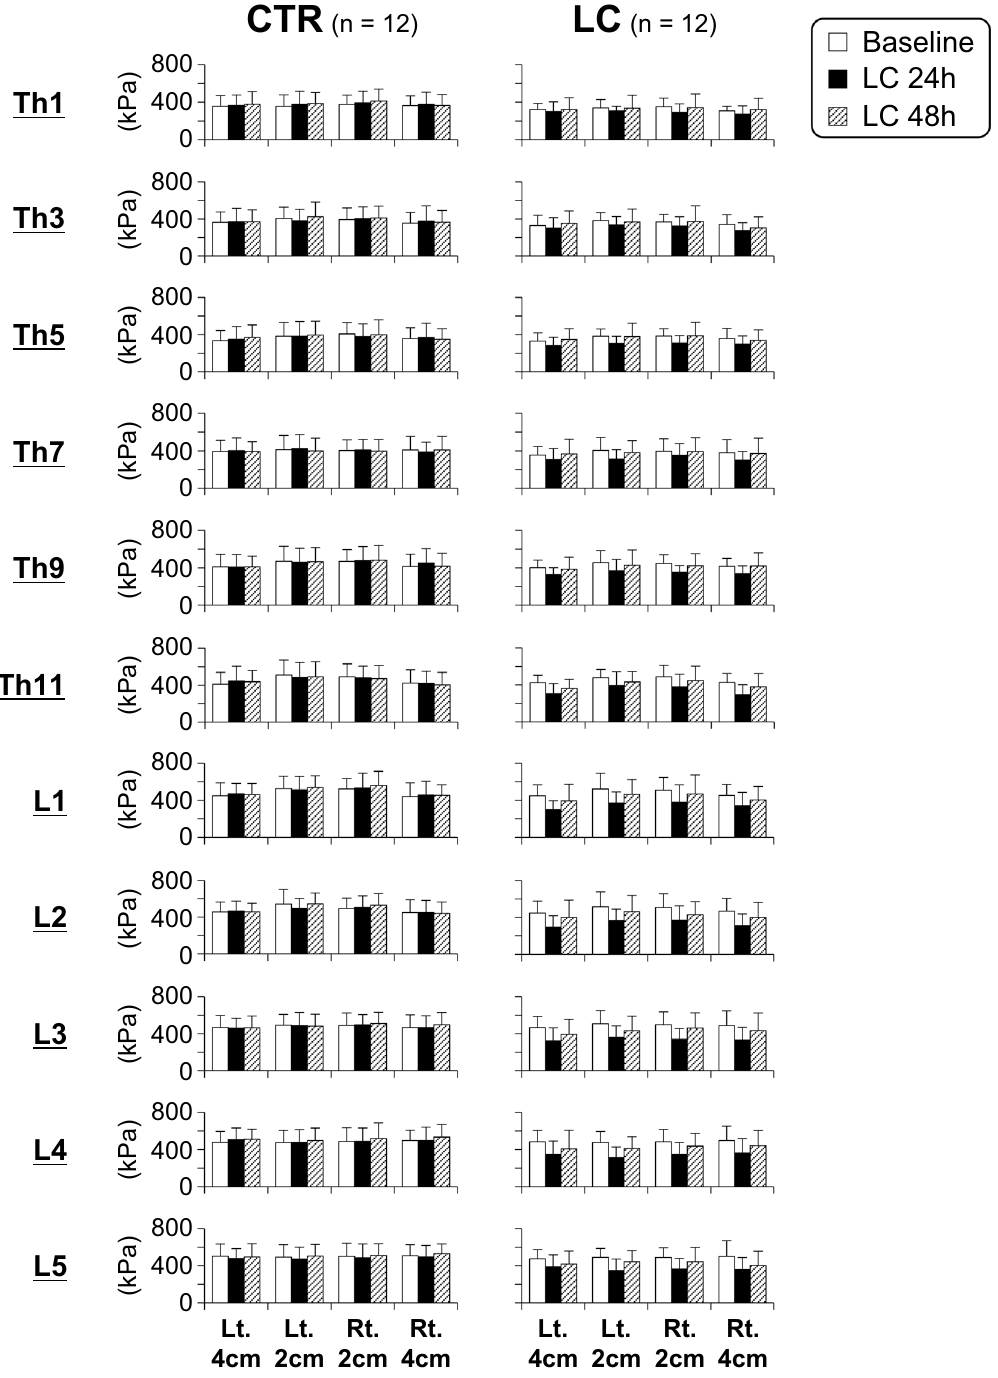
Figure 5. Changes in pressure pain thresholds (PPTs) after lengthening contractions (LCs). PPTs in the thoracolumbar paraspinal muscles 0 (before), 24, and 48 h after LCs. Data are shown as mean ± SD in the CTR (n = 12) and LC groups (n = 12). See Supplementary Table 2 for detailed PPT values. Note that PPTs decreased 24 h after LC in the LC group, and that the decrease was prominent at segments from the lower thoracic to lumbar areas. In contrast, PPTs in the CTR group remained unchanged over